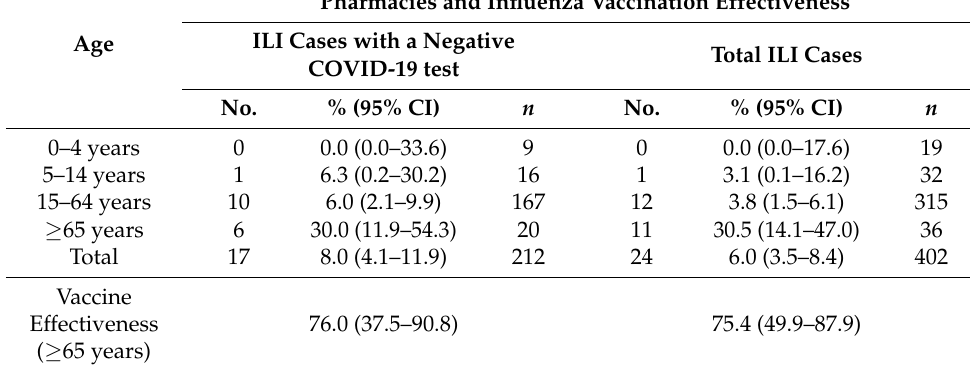
Table 2. Influenza vaccination coverage in influenza-like illness (ILI) cases reported by sentinel pharmacies and influenza vaccination effectiveness in individuals aged 65 years or more in Catalonia, Spain, in the 2021–2022 influenza